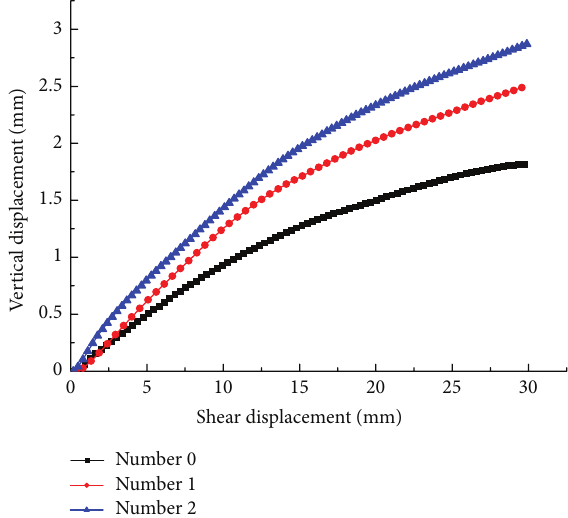
Figure 10: The maximum shear stress versus the normal stress for interfaces of different roughness.